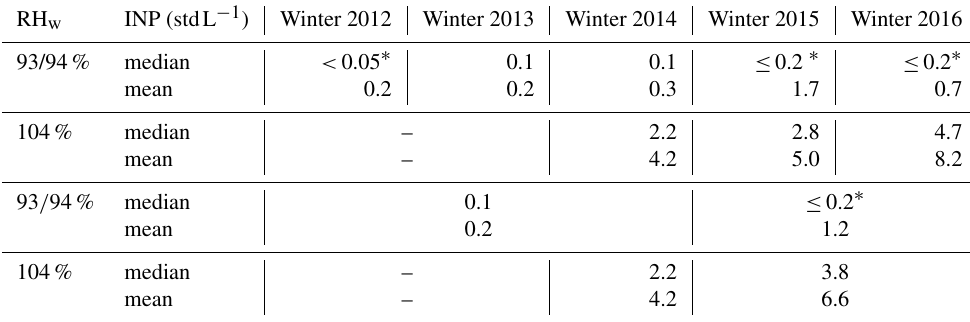
Table 2. Campaign INP concentrations (stdL − 1 ) excluding known cases of high INP concentrations, as measured with PINC (winter 2012– 2014) and HINC (winter 2015 and 2016). Values are given for each field campaign (rows 1 and 2) and as averages over the PINC and HINC campaigns (rows 3 and 4). Measurements above water saturation were not conducted prior to 2014. INP concentrations here consider data below the LOD and can therefore differ from values reported in Boose et al. (2016a). RH w INP (stdL − 1 )